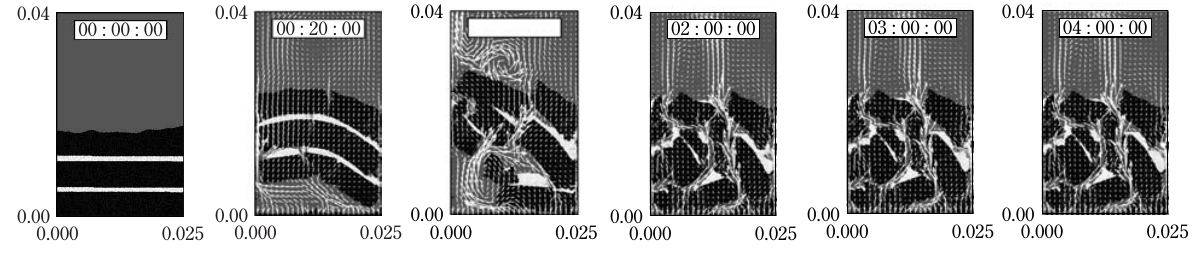
Fig. 1 The gas-solid flow patterns with an initial two layers of 5,000 cohesionless (white) particles placed alternatively in the bed of 40,000 cohesive (black) particles at u/u mf (cid:1) 4.8. The ratio of the maximum cohesive force at z min to particle weight is 338.